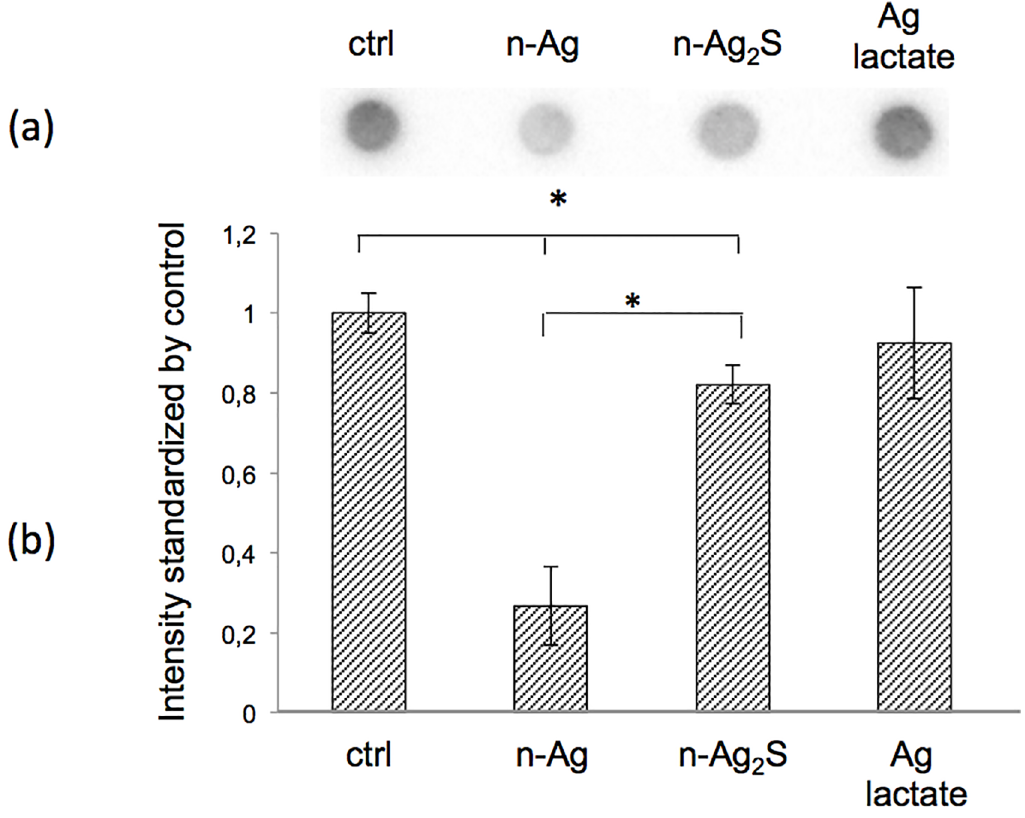
Fig 5. PGA interacts specifically with silver nanoparticles (n-Ag). (a) Representative dot blot of PGA after incubation of cell- free supernatant with n-Ag, n-Ag 2 S or Ag lactate. (b) Quantification of dot blot. The intensity was normalised by the control and the amount of proteins. Error bars ± 1 standard deviation ( n (cid:21) 3). Asterisks ( (cid:3) ) indicate significant differences vs the control ( p <